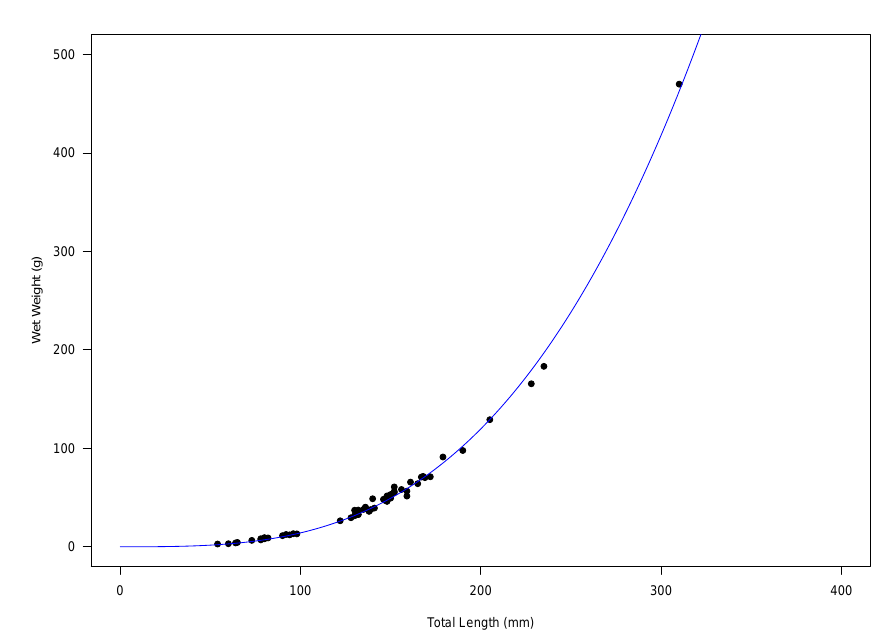
Figure 1. Relationship of Lethrinus. harak total length (mm) to fish weight (g). Data are represented by the black dots and the line represents the model W = 9.614 e − 06 L 3.084 , where W and L represent individual weight and length,